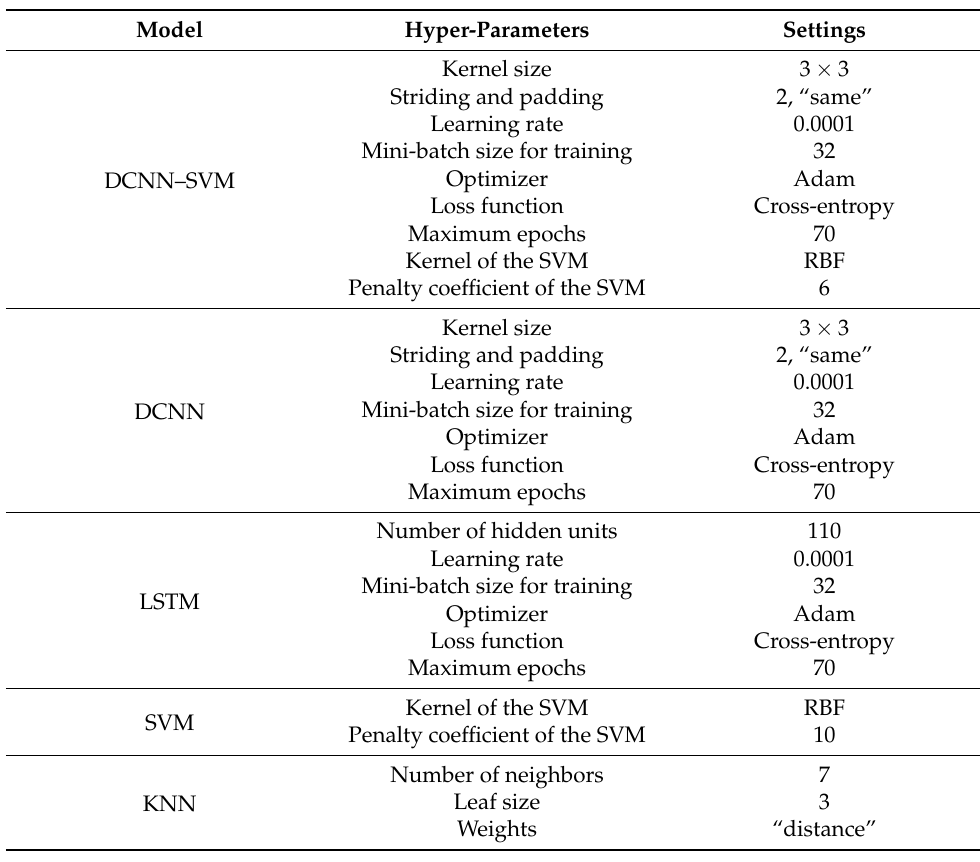
Table 4. Settings of the hyper-parameters of the compared